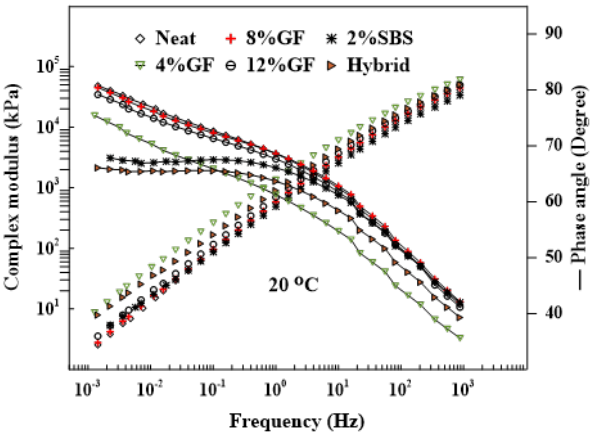
Figure 3. Master curve of asphalt binders at 20 ◦